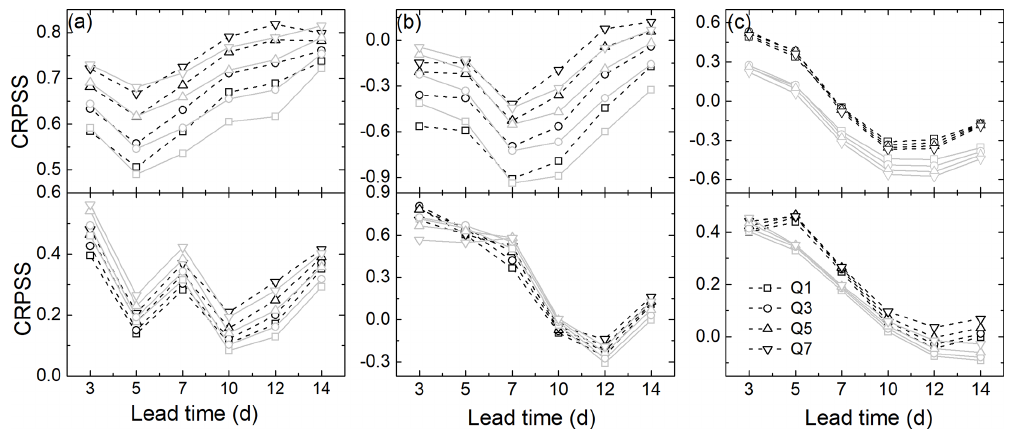
Figure 6. CRPSS for different typical accumulated flood volumes against lead time. The upper panels are results for first floods, and the lower panels are for maximum floods. Scores derived from S -simulation sets are marked in black, while results for N simulations are in grey.